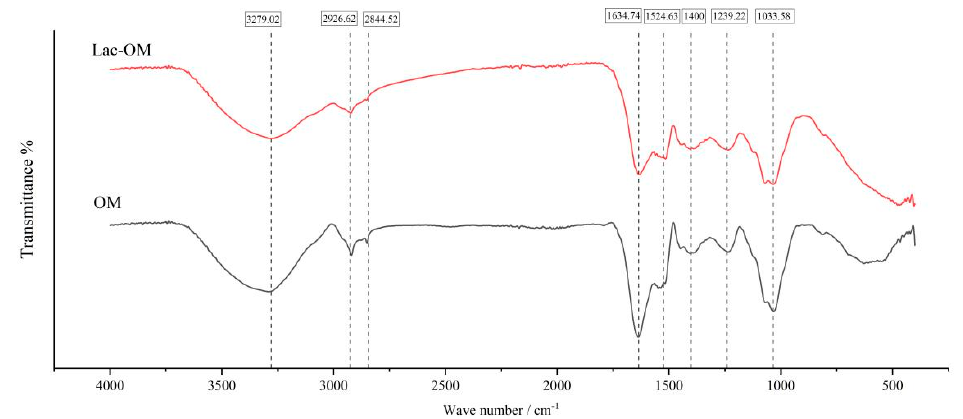
Figure 3. FTIR of organic matter derived from leaf and laccase-modified organic matter.